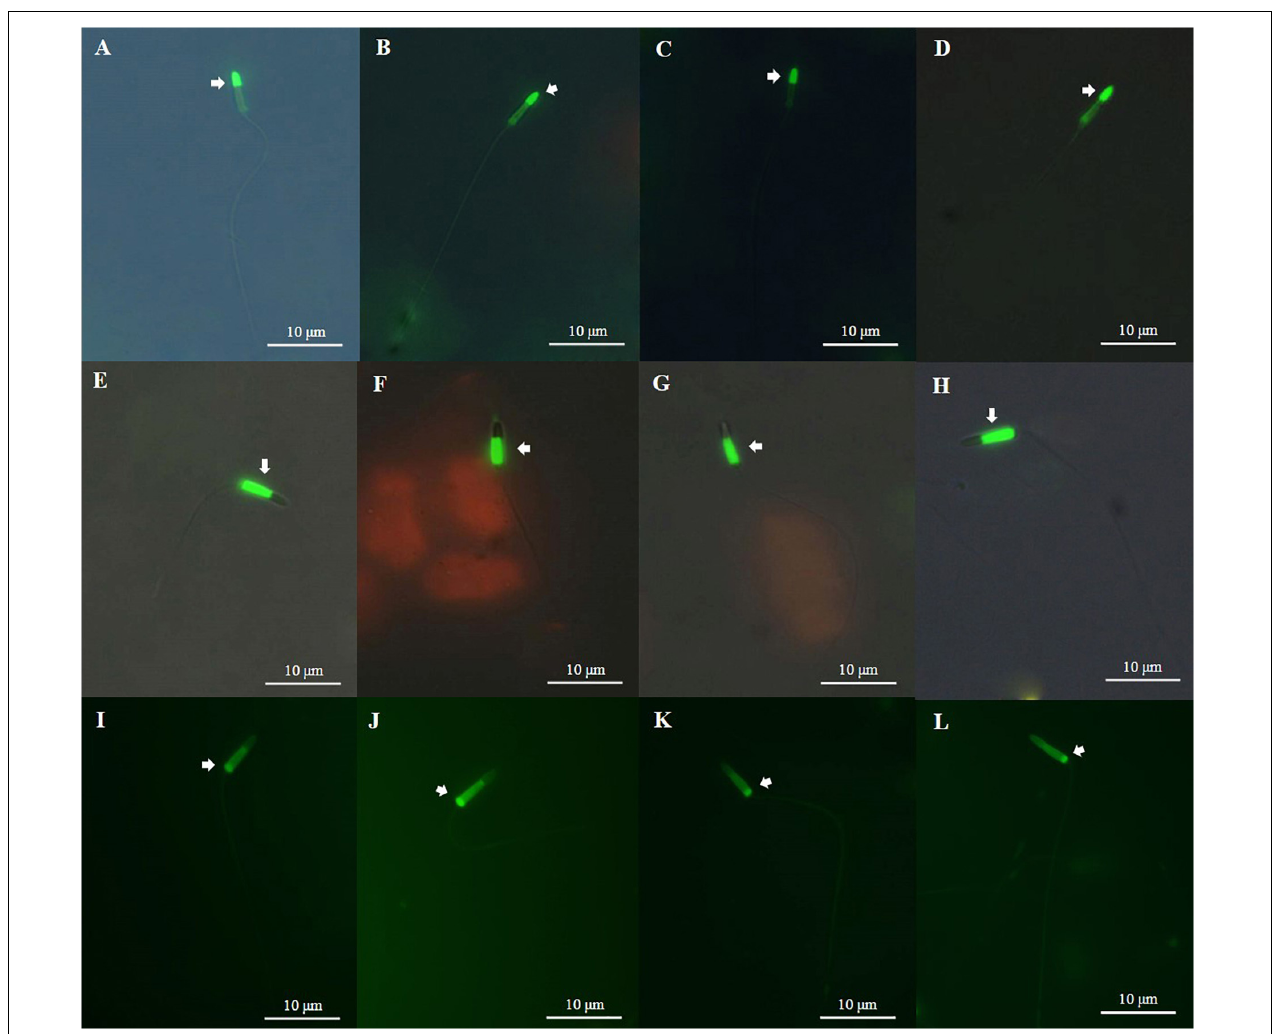
FIGURE 5 | Fluorescently stained photographs of Pacific abalone sperm. (A) Acrosome integrity (AI) of fresh sperm; (B) AI of sperm cryopreserved with 8% ethylene glycol (EG); (C) AI of sperm cryopreserved with 6% propylene glycol (PG); (D) AI of sperm cryopreserved with 2% MeOH; (E) plasma membrane integrity (PMI) of fresh sperm; (F) PMI of sperm cryopreserved with 8% EG; (G) PMI of sperm cryopreserved with 6% PG; (H) PMI of sperm cryopreserved with 2% MeOH; (I) mitochondrial membrane potential (MMP) of fresh sperm; (J) MMP of sperm cryopreserved with 8% EG; (K) MMP of sperm cryopreserved with 6% PG; and (L) MMP of sperm cryopreserved with 2%